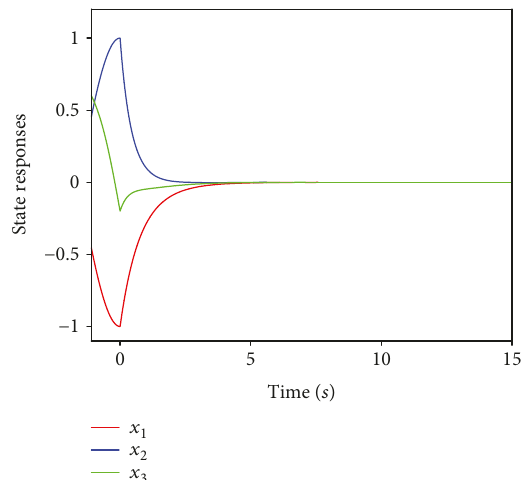
Figure 4: State responses of the considered SNNs for Example 1 with the initial condition ψ s = 3 5 ; 3 8 ; − 3 8 T .